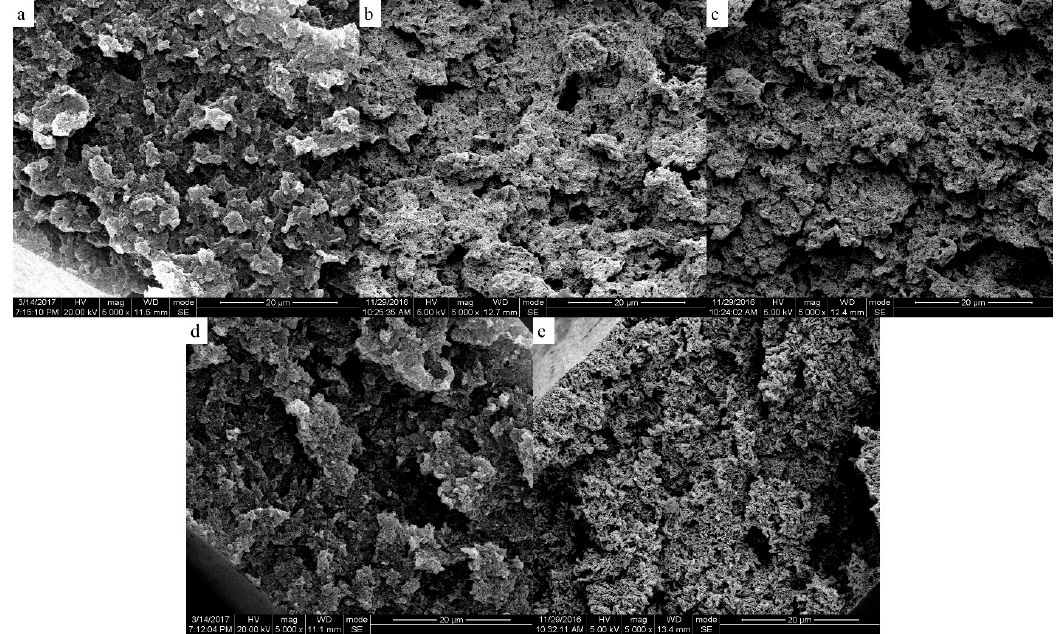
Figure 6. Scanning electron micrographs of the cross-section of the membrane; samples were cold crystallized at ( a ) 240 ◦ C; ( b ) 250 ◦ C; ( c ) 260 ◦ C; ( d ) 270 ◦ C; ( e ) 280 ◦ C.